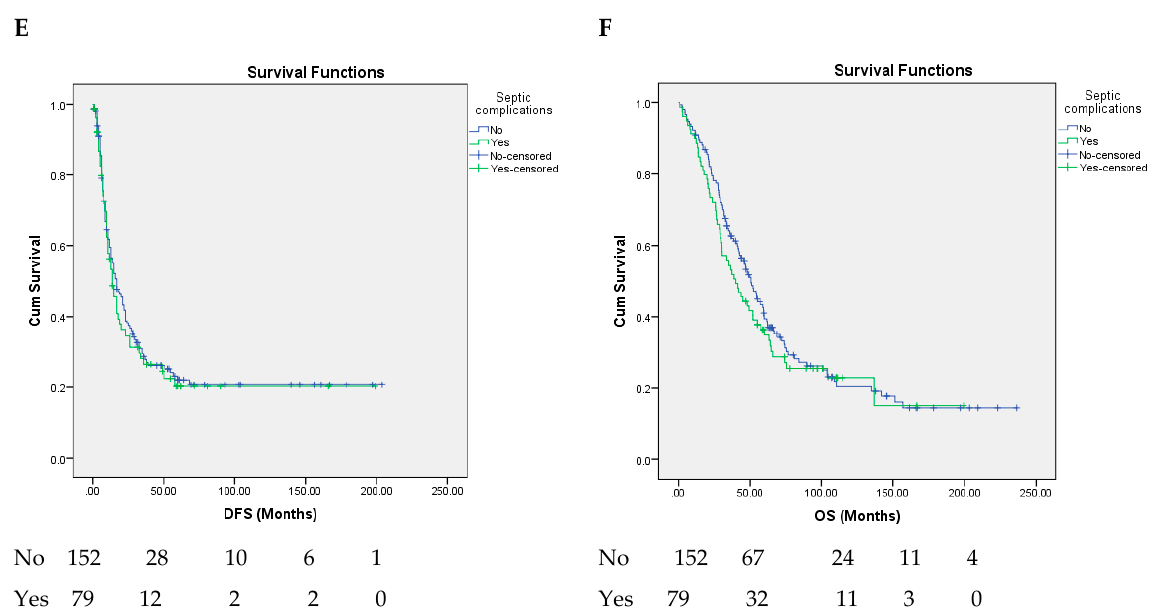
Figure 2. Kaplan–Meier curve of with SCLMs resected comparing ( A ) disease-free survival for com- plications vs. no complications, p = 0.245; ( B ) overall survival for complications vs. no complications, p = 0.488; ( C ) disease-free survival for patients without complications or with mild complications vs. severe complications, p = 0.907; ( D ) overall survival for patients without complications or with mild complications vs. severe complications, p = 0.727; ( E ) disease-free survival for septic complications vs. no septic complications, p = 0.661; ( F ) overall survival for septic complications vs. no septic complications, p = 0.391.